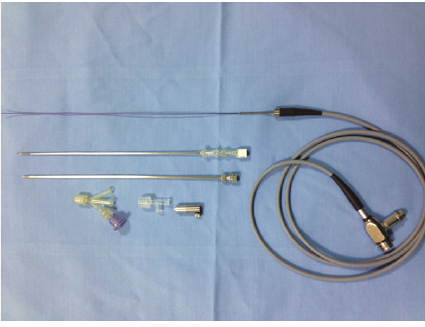
Figure 2: Needle, flexible microfiber optic, and three-way adaptor.